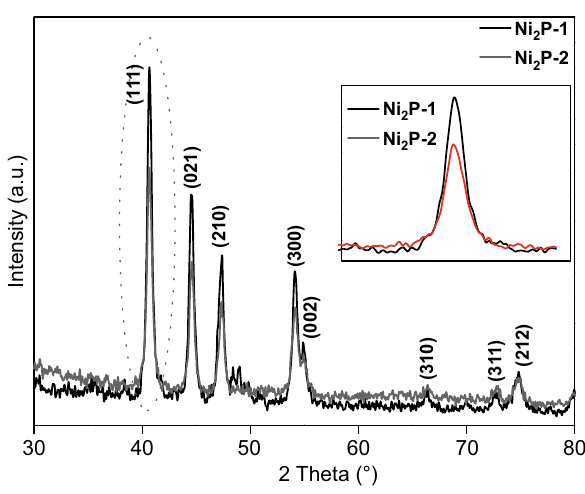
Fig. 7 Ni 2 P‑1 and Ni 2 P‑2 XRD